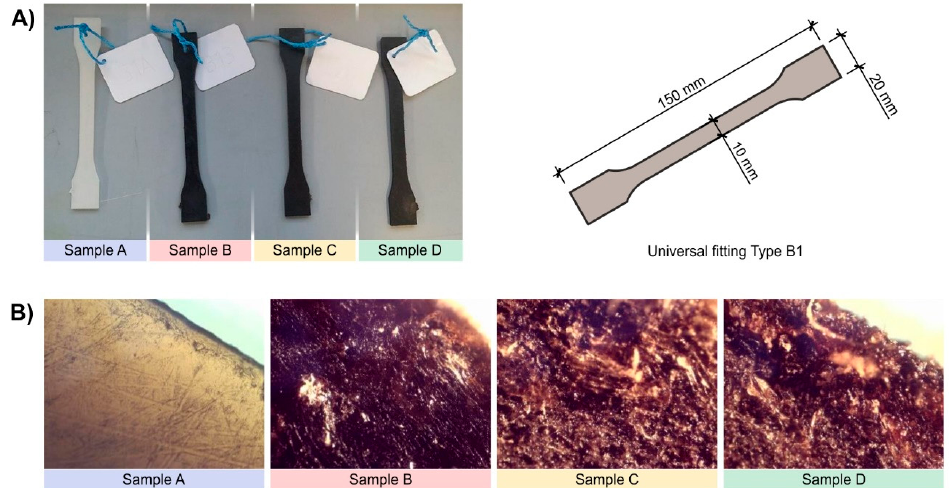
Figure 1. ( A ) Samples (paddles) of high-density polyethylene (PE-HD) and with the addition of SCG with a nameplate, ( B ) Microscopic images of test paddles, magnification 160